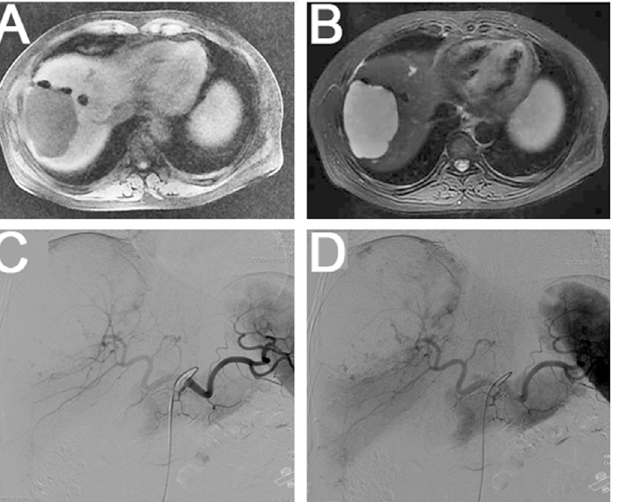
Fig 2. MRI scan. A giant oval mass with low signal in T1WI (A) and high signal in T2WI, appearing as the “ light bulb ” sign (B). DSA showing intrahepatic massive and multiple nodular tumors, developing in the early arterial phase and gradually filling to the interior, appearing as the “ fast out, slow in, tree bearing fruit ” sign (C and